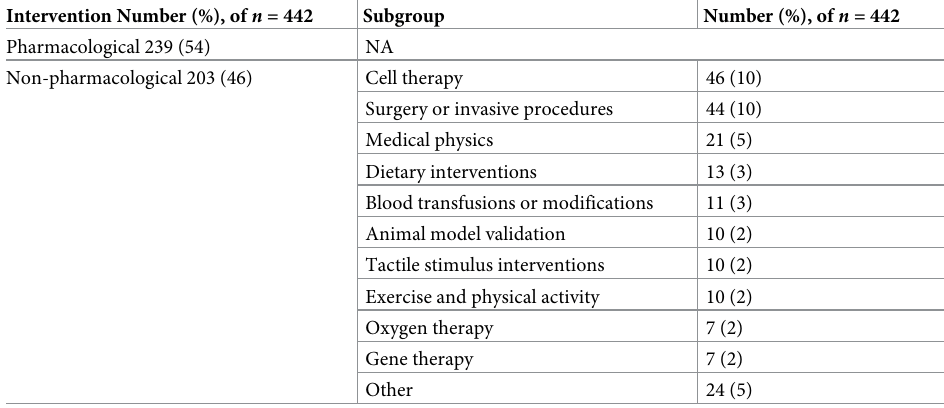
Table 3. Intervention and intervention subgroups evaluated in the preclinical systematic